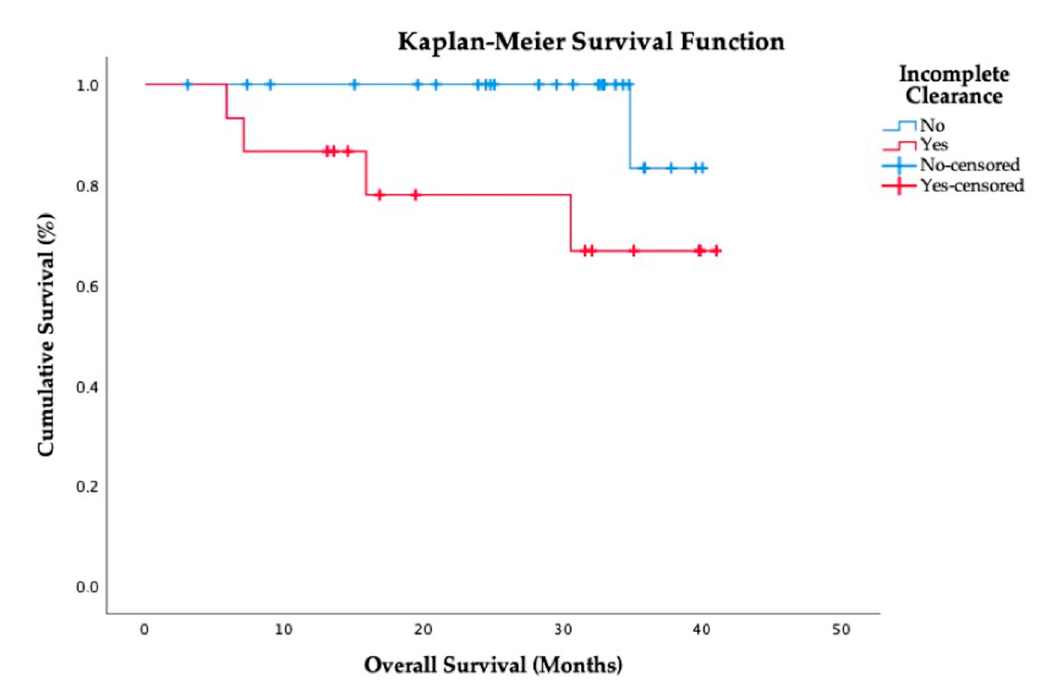
Figure 2. Kaplan–Meier curve showing the relationship between incomplete clearance of CTCs at post-operative day 30 and mortality.